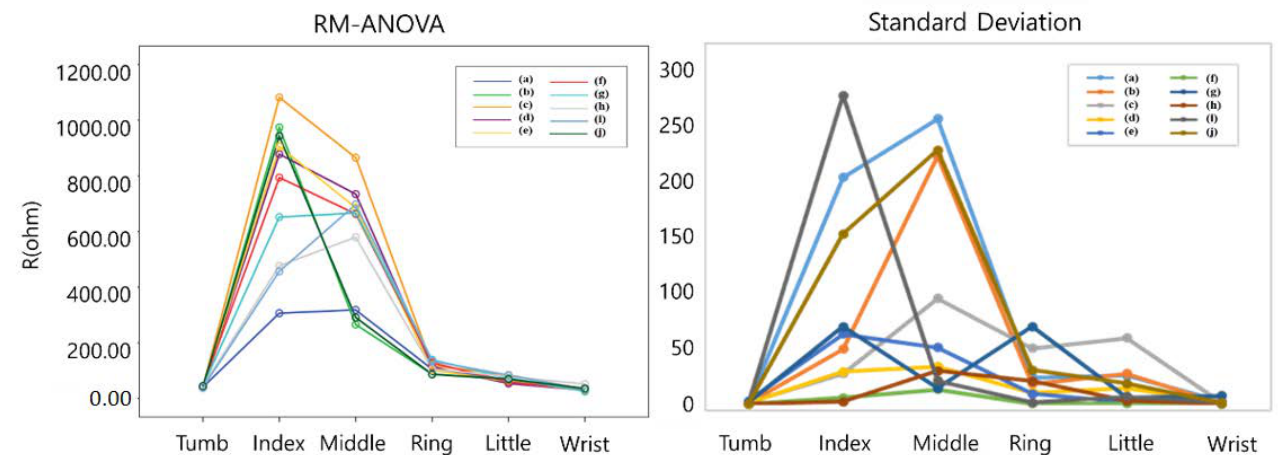
Figure 11. Repeated-measures analysis of variance (RM-ANOVA) and standard deviation of electrical resistances variations according to 10 hand postures, where ( a ) grasp, ( b ) one, ( c ) two, ( d ) three, ( e ) four, ( f ) five (resting), ( g ) wrist flexion, ( h ) wrist extension, ( i ) okay, and ( j ) pinch.